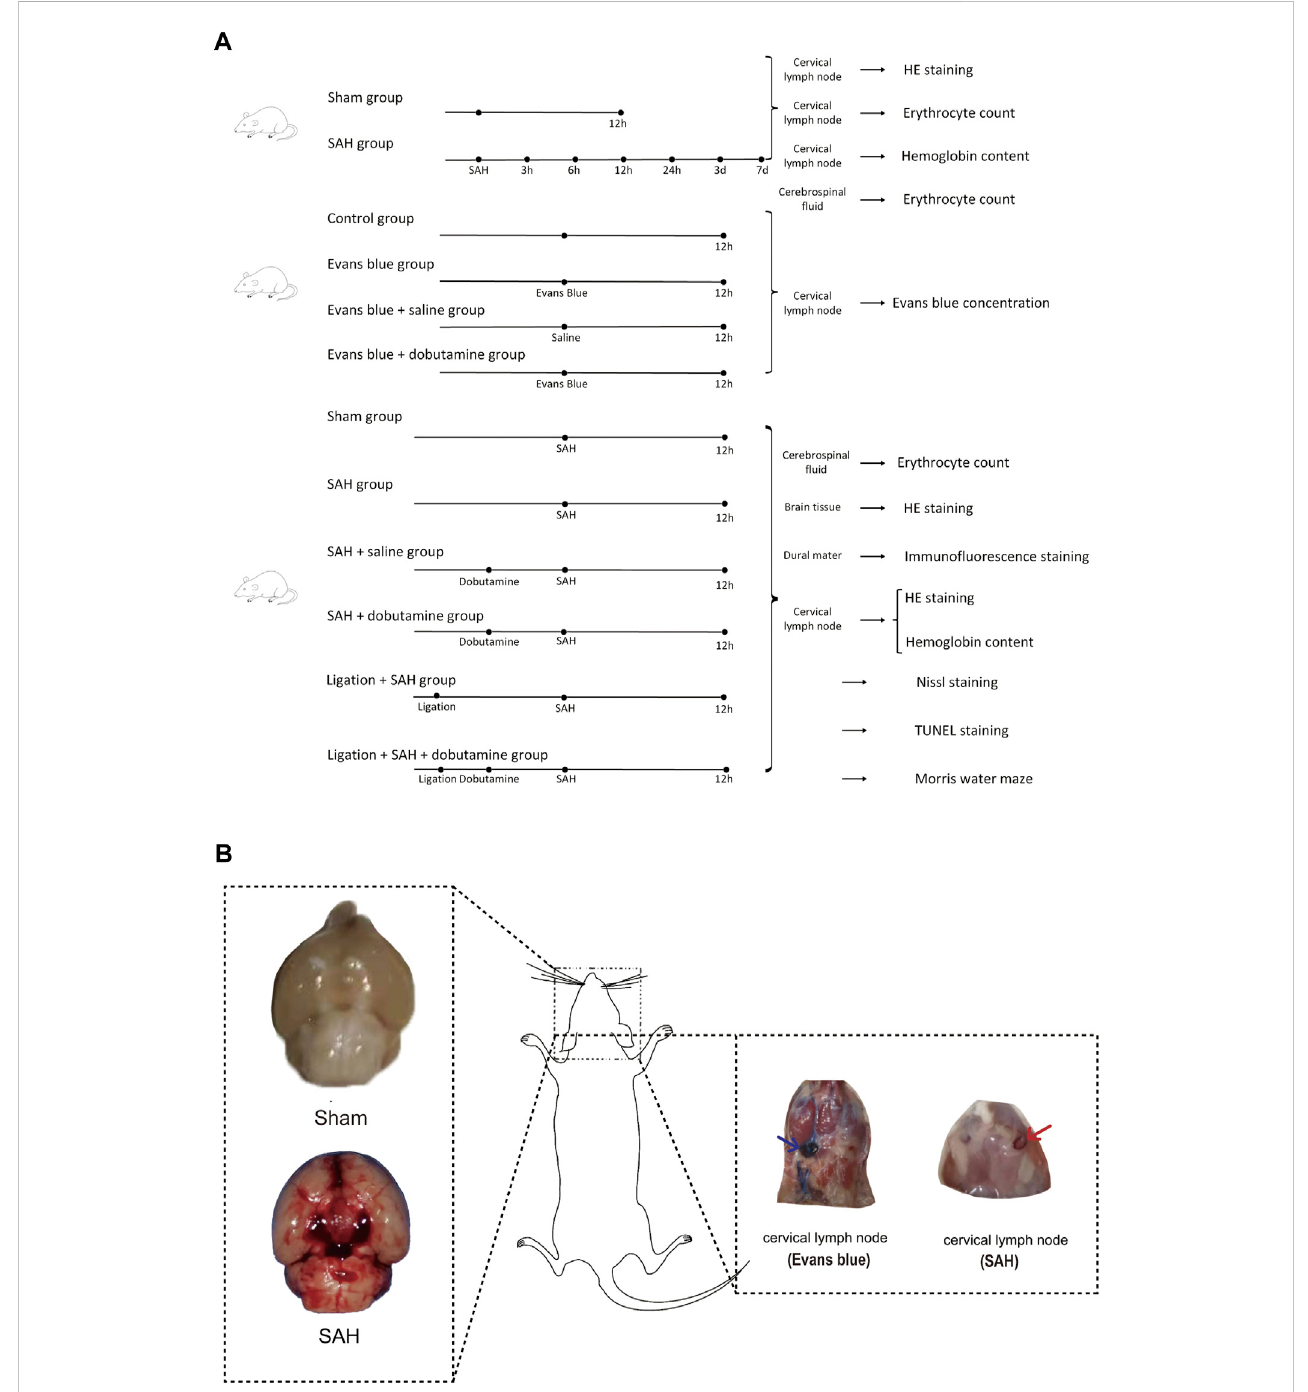
FIGURE 2 Experimental design of the present study and gross appearances of the SAH model and dCLN drainage of Evans blue and erythrocytes. (A) We fi rst collected dCLNs from the sham and SAH groups for hematoxylin – eosin staining (HE staining). We then compared the Evans blue concentration of dCLNs amongthecontrol,Evansblue,Evansblue+saline,andEvansblue+dobutaminegroups.Finally,cerebrospinal fl uid,braintissue,duramater,anddCLNswere isolatedandcollectedfordifferentanalysesofthesham,SAH,SAH+saline,SAH+dobutamine,ligation+SAH,andligation+SAH+dobutaminegroups. (B) Gross appearances of the skull base in the sham group (upper left insert) and SAH model (lower left insert). The right panel shows the gross observation of dCLNs after Evans blue staining (blue arrow) and RBC injection (red